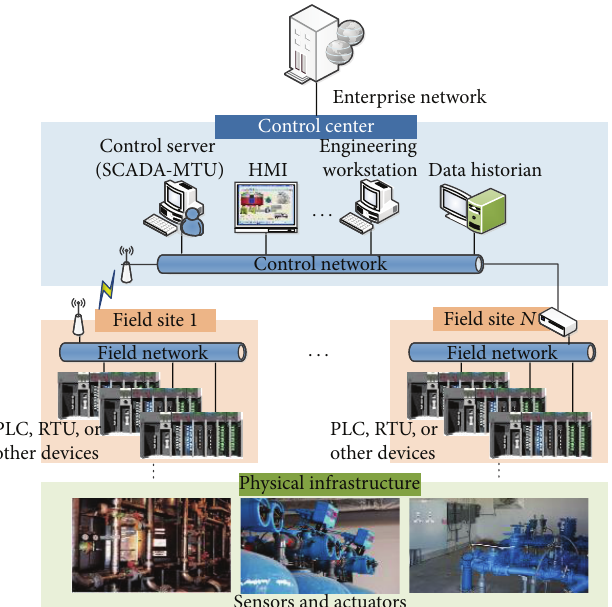
Figure 1: SCADA system general layout.